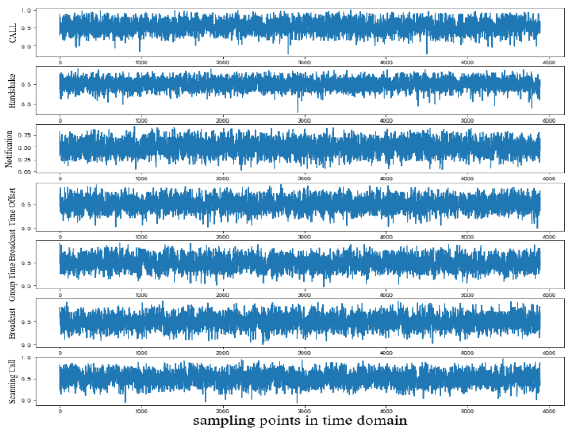
Figure 6. Seven kinds of LE behavior signals generated by unidimensional ACGAN.